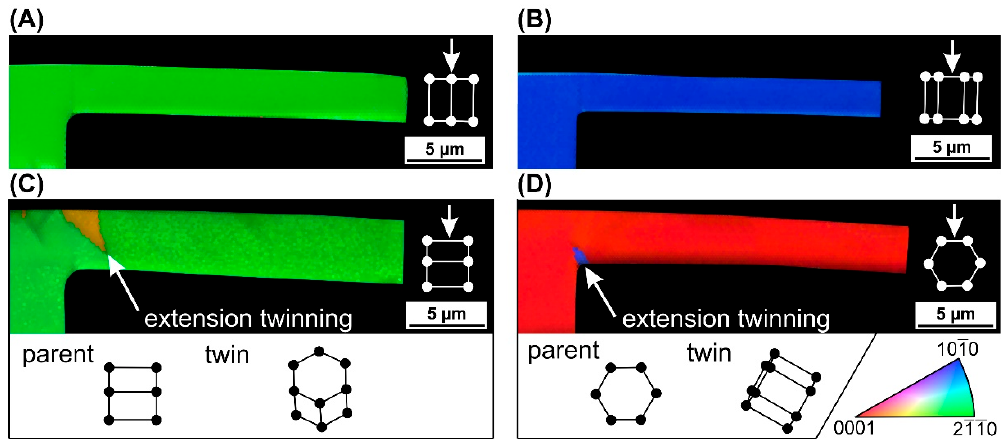
Figure 2. The electron backscatter diffraction (EBSD) analysis of the longitudinal sections of the cantilever samples. The labels ( A – D ) correspond to the sample crystallographic orientations (A-D). All the crystal-structure schematics are shown from lateral view of a selected microcantilever. The arrows represent the direction of the acting force.